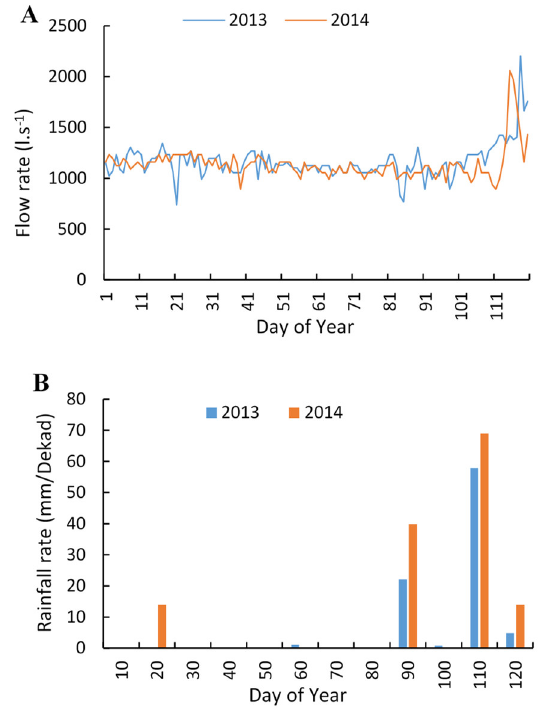
Figure 3. Water flow rates of the main canal ( A ) and rainfall rates ( B ) in the Kou Valley irrigation scheme during the study period. Table 2. Values of harvest index (HI) and moisture content for paddy rice, maize, and sweet potato used in this study. HI and moisture contents were chosen to reflect the common crop management practices across the Kou Valley irrigation